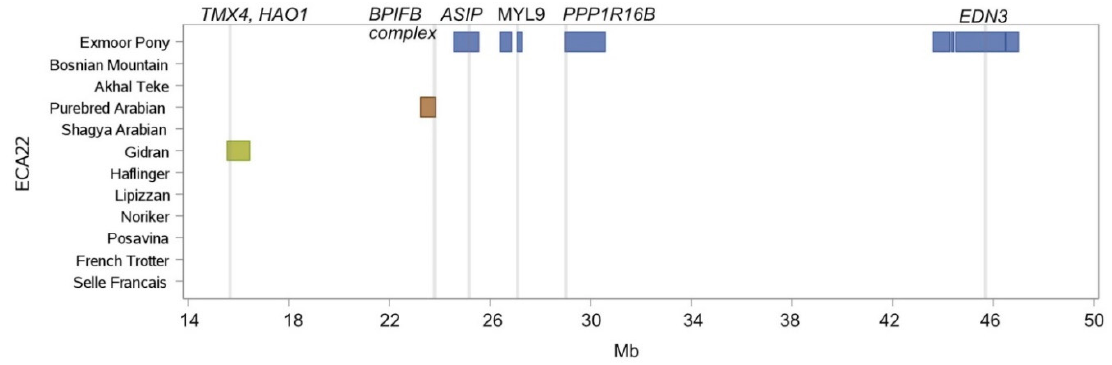
Figure 6. ROH islands on ECA22 between 14 Mb and 50 Mb. Location and length of ROH islands (shared by more than 50% of individuals per breed) per breed are illustrated as horizontal boxes, location of genes of specific interest are indicated as vertical lines.